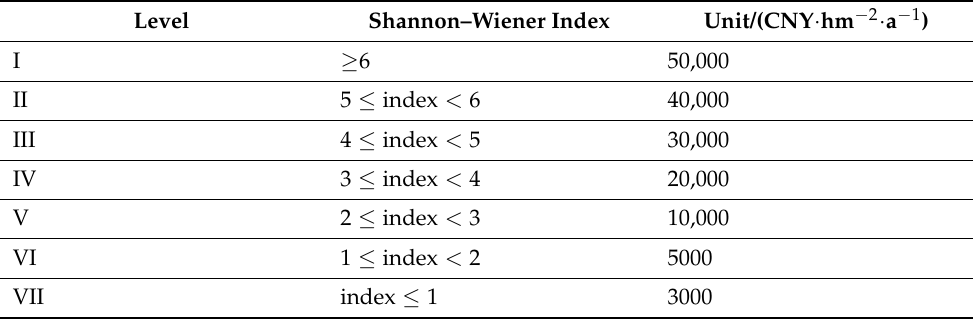
Table 4. Shannon–Wiener index classification and